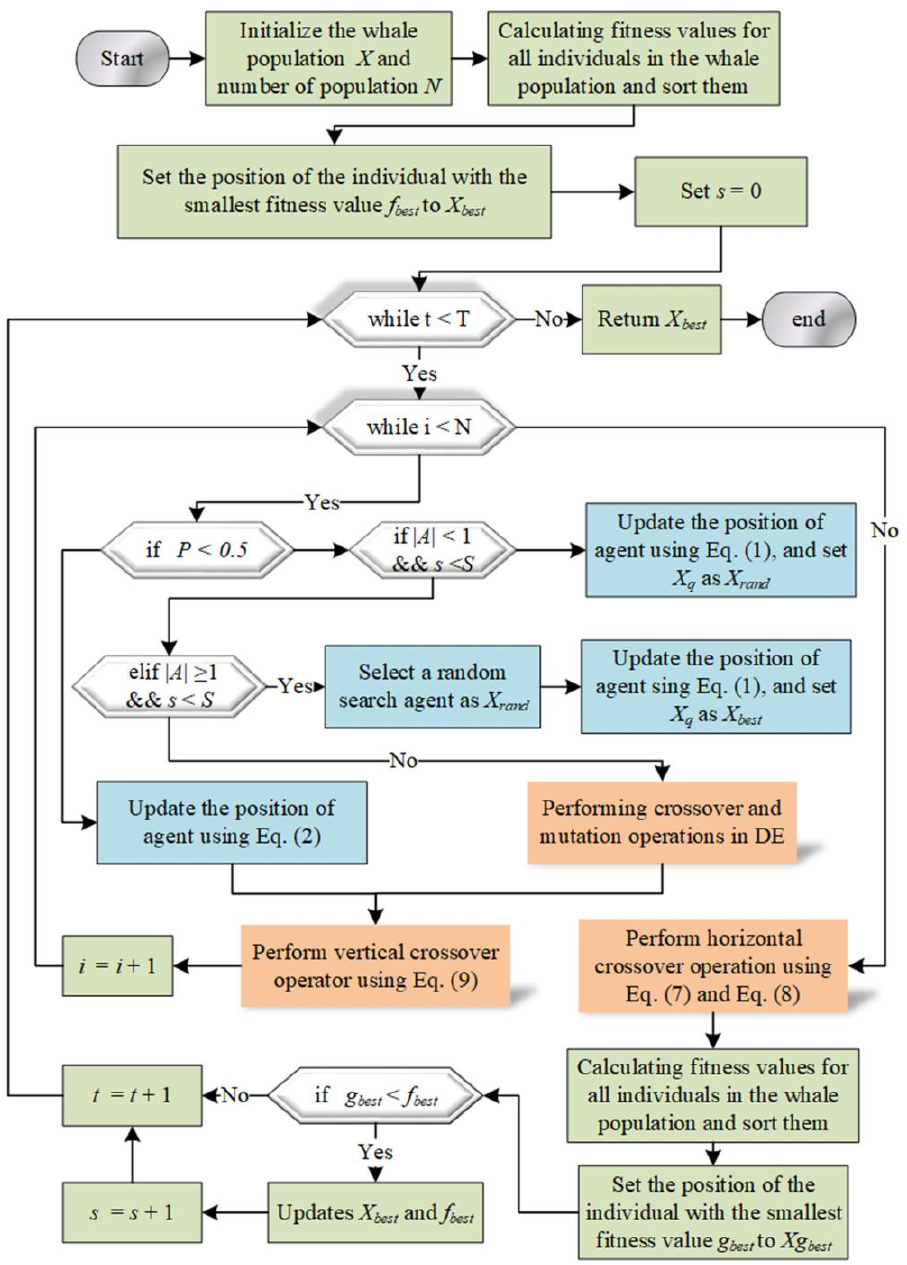
Figure 3. Flow chart of the DECCWOA framework.